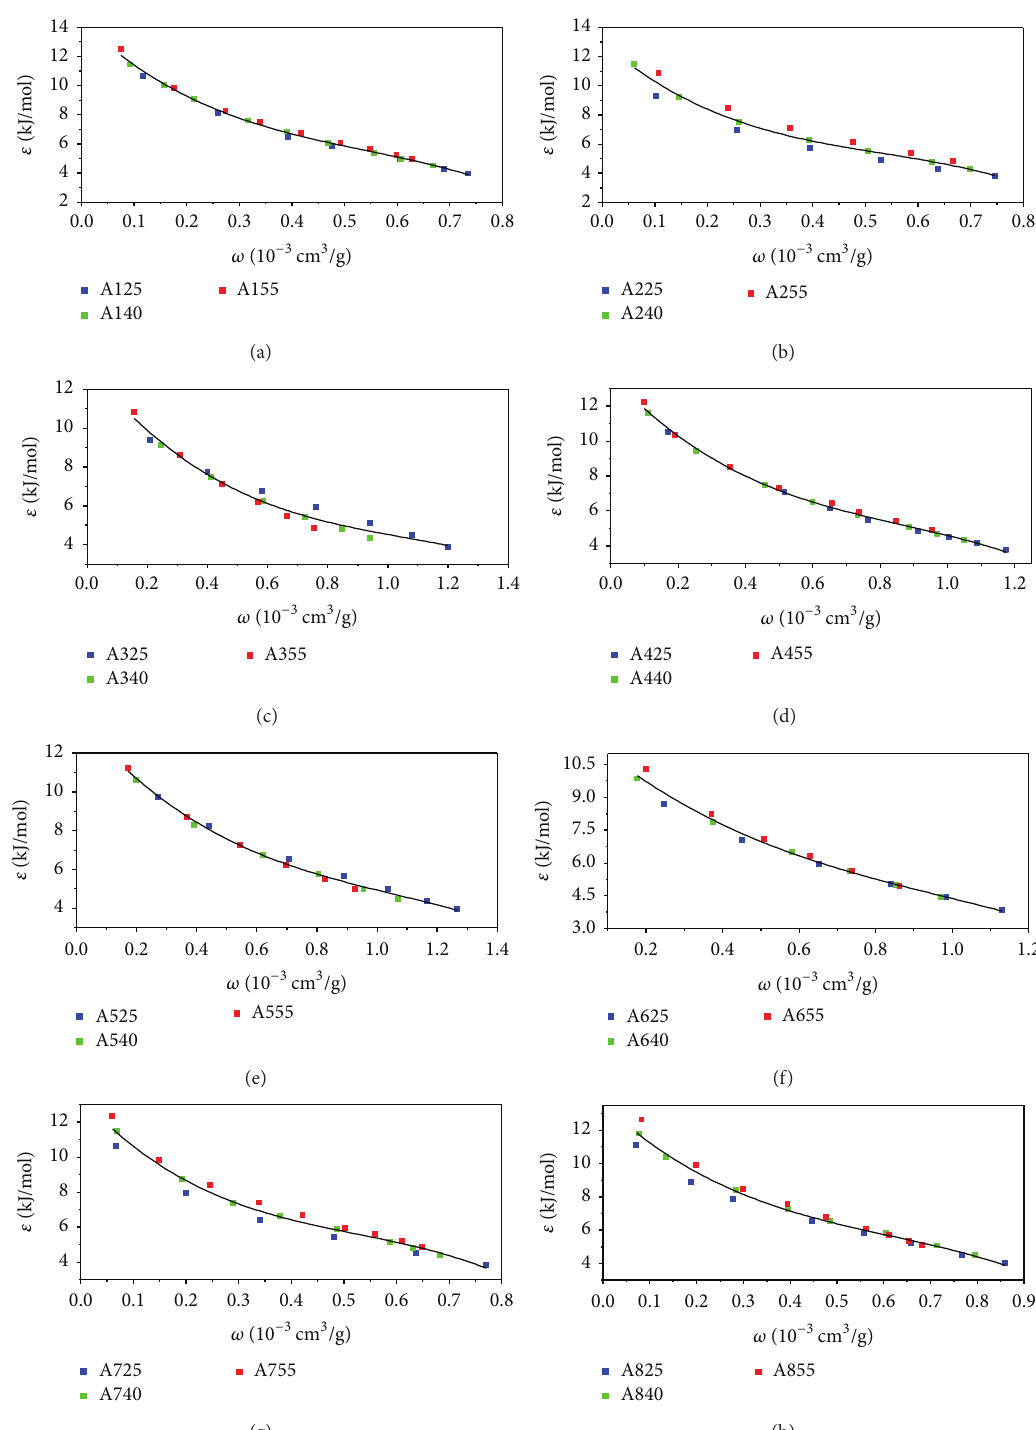
Figure 6: Characteristic curves for methane on (a) A1, (b) A2, (c) A3, (d) A4, (e) A5, (f) A6, (g) A7, and (h) A8 at 298 K, 313.15 K, and 328.15 K,